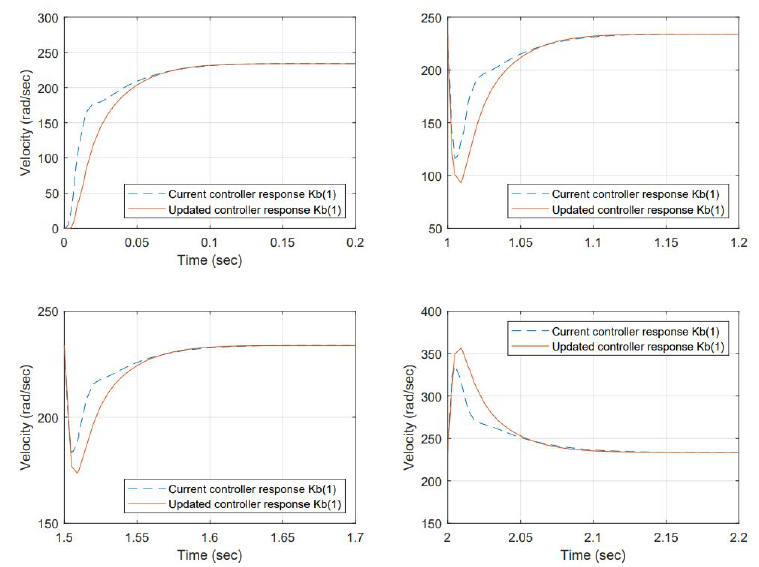
Figure 14. System response to a Back EMF change ( K b = 0.0385)—sample 1. The dynamic